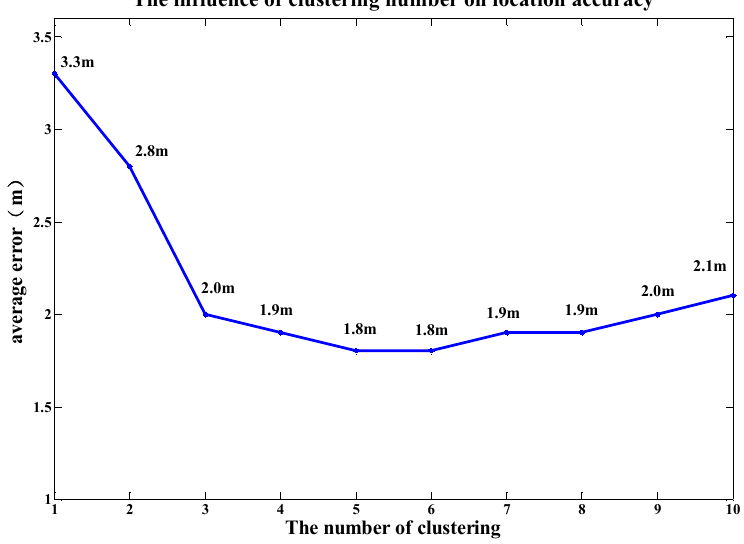
Figure 14. The impact of clustering number on location accuracy.